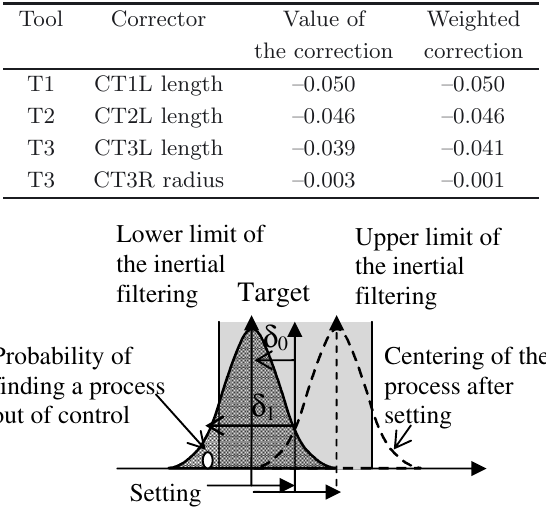
Fig. 2. The problem of determining an adjustment.